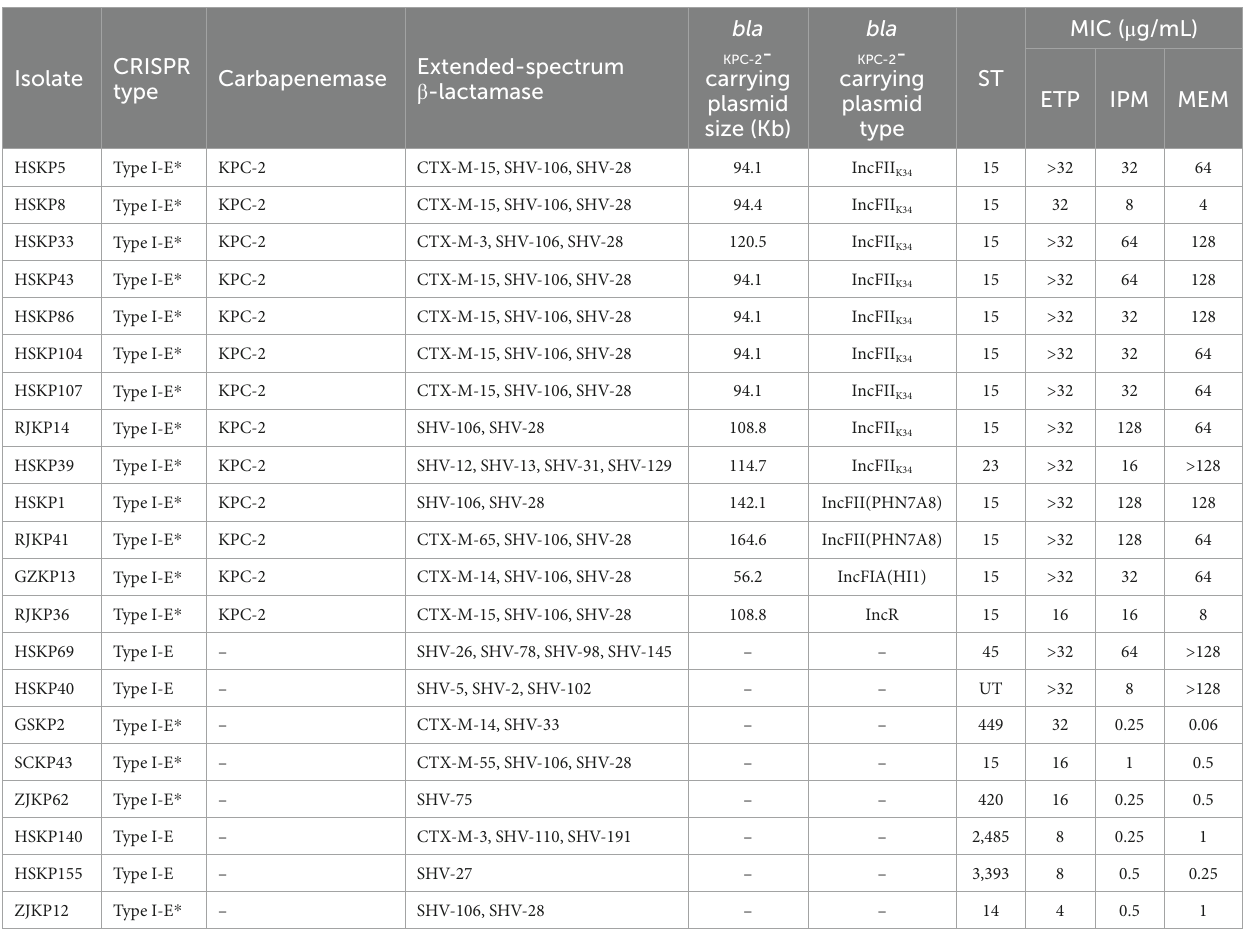
TABLE 3 Characteristics of 21 CRKP clinical isolates carrying CRISPR-Cas systems.